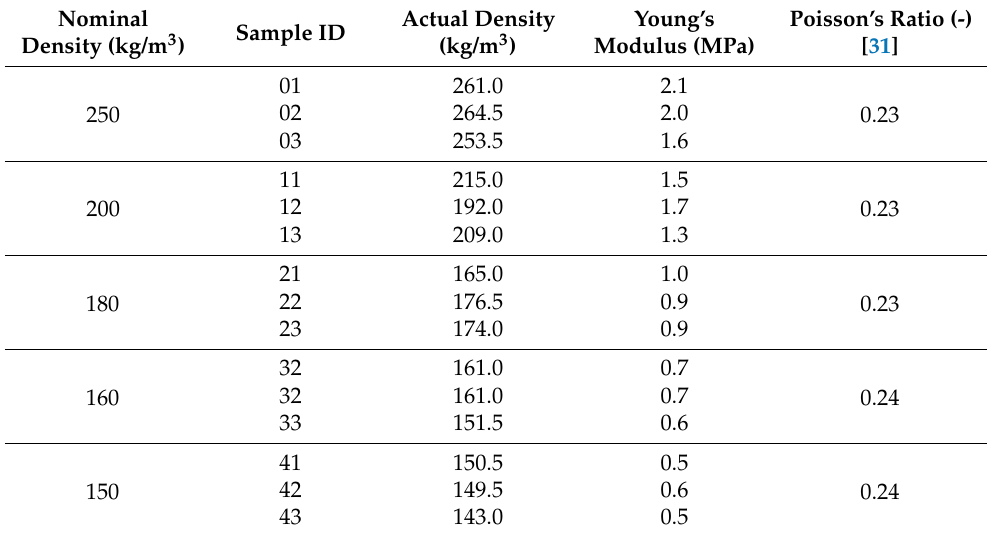
Table 3. Nominal and actual density of tested samples, with Young’s modulus (own elaboration) and Poisson’s ratio [31].